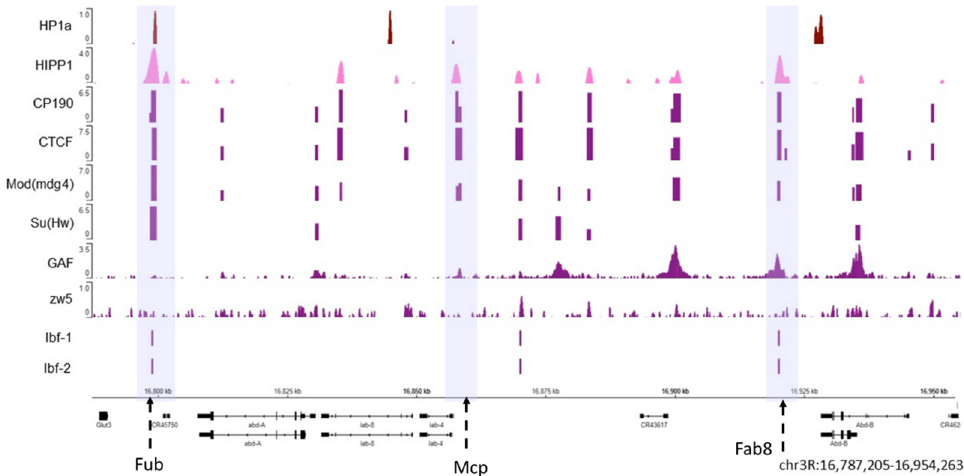
Figure 4. The HP1a and HIPP1 proteins co-localize at homeotic genes along with the AP. The HP1a and HIPP1 proteins co-localize at the Fub insulator (the first violet box) in the Abd-a gene along with CP190, Su (Hw), CTCF, and Mod (mdg4), and Ibf 1 and 2. From the previously published ChIP data on S2 cells, we find HP1a (dark red), HIPP1 (pink), and some architecture proteins (purple). The adjacent insulators Mcp and Fab8 do not co-localize with HP1a (center and right violet boxes). The regions with insulators are marked with dotted arrows inside a violet shadow. At the bottom are the Abd-a and Abd-b genes and their locations; the reference in kilobases.